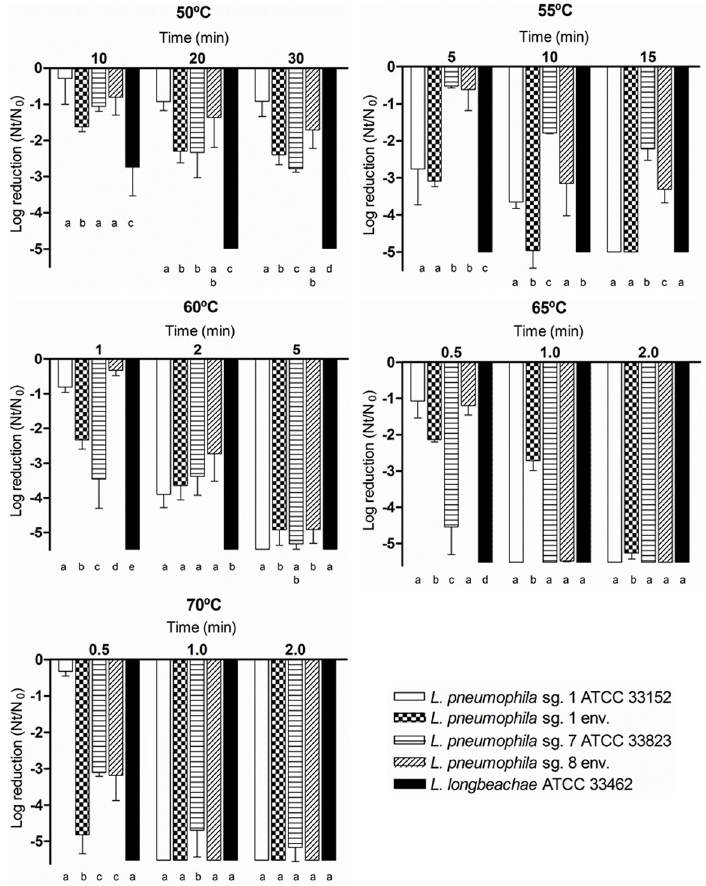
Fig 3. Effect of thermal treatments on the inactivation of 5 Legionella strains. Bacterial inactivation was determined using viable counts on BCYE agar medium. Data are presented as means ± SD (columns and error bars; n = 3). Statistical differences between means within each time point were represented assigning different letters to the bar plot. The same letter was assigned to bars with no significant differences between them. Statistical analyses were performed by ANOVA and pairwise Fisher ’ s LSD test ( p < 0.05). doi:10.1371/journal.pone.0134726.g003 depending on the amoeba strain (Fig 4). Whereas bacterial loads increased 1.3 logs after 48 h within A . castellanii CCAP 1534/2, bacterial loads increased 2 logs within Acanthamoeba sp. 155. In parallel, a negative control showed that L . pneumophila sg. 1 environmental did not grow on PYG media without the presence of amoebae. On the other hand, the results obtained